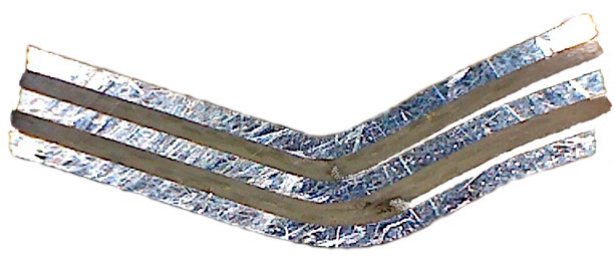
Figure 23. Failure mode after short-beam three-point-bending test with a span-to-thickness ratio of 4.